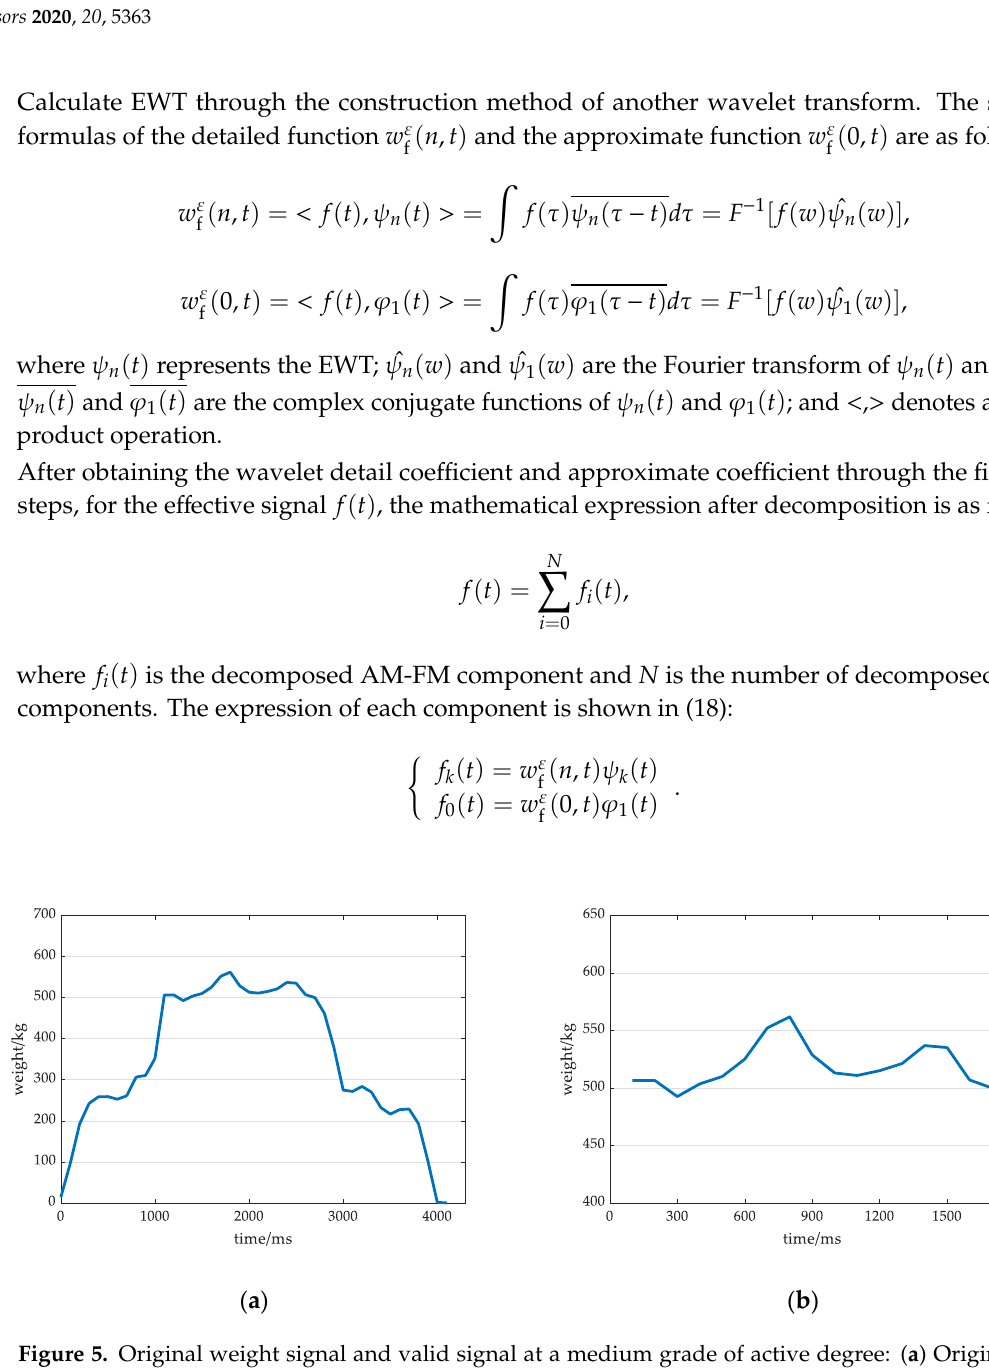
Figure 6. EWT decomposition diagram for a medium-grade activity signal. 3.